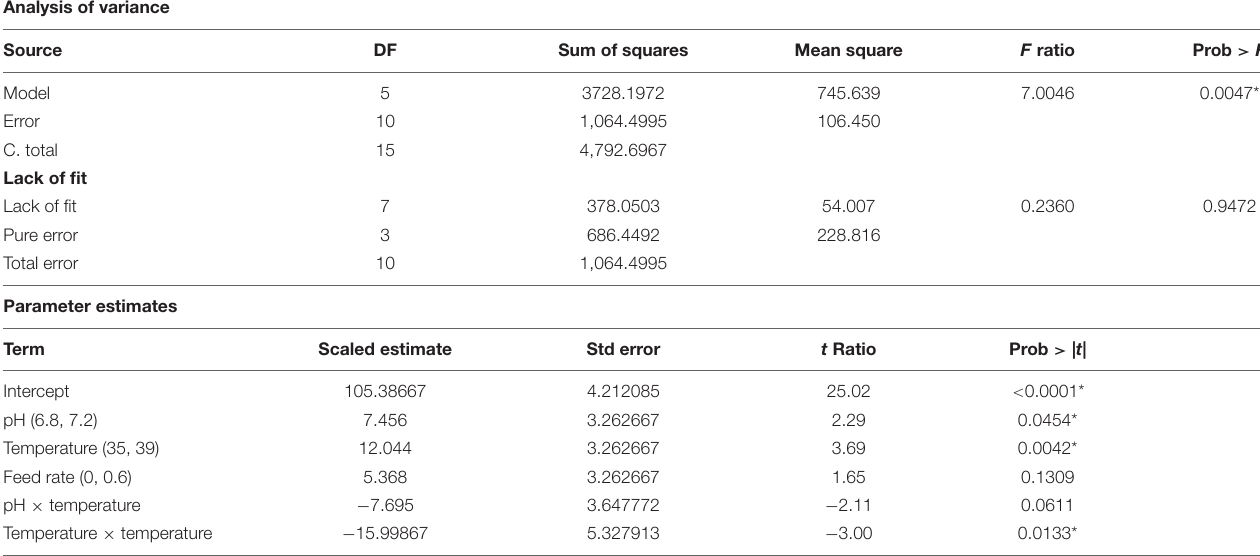
TABLE 4 | Regression analysis of predicted models for volumetric